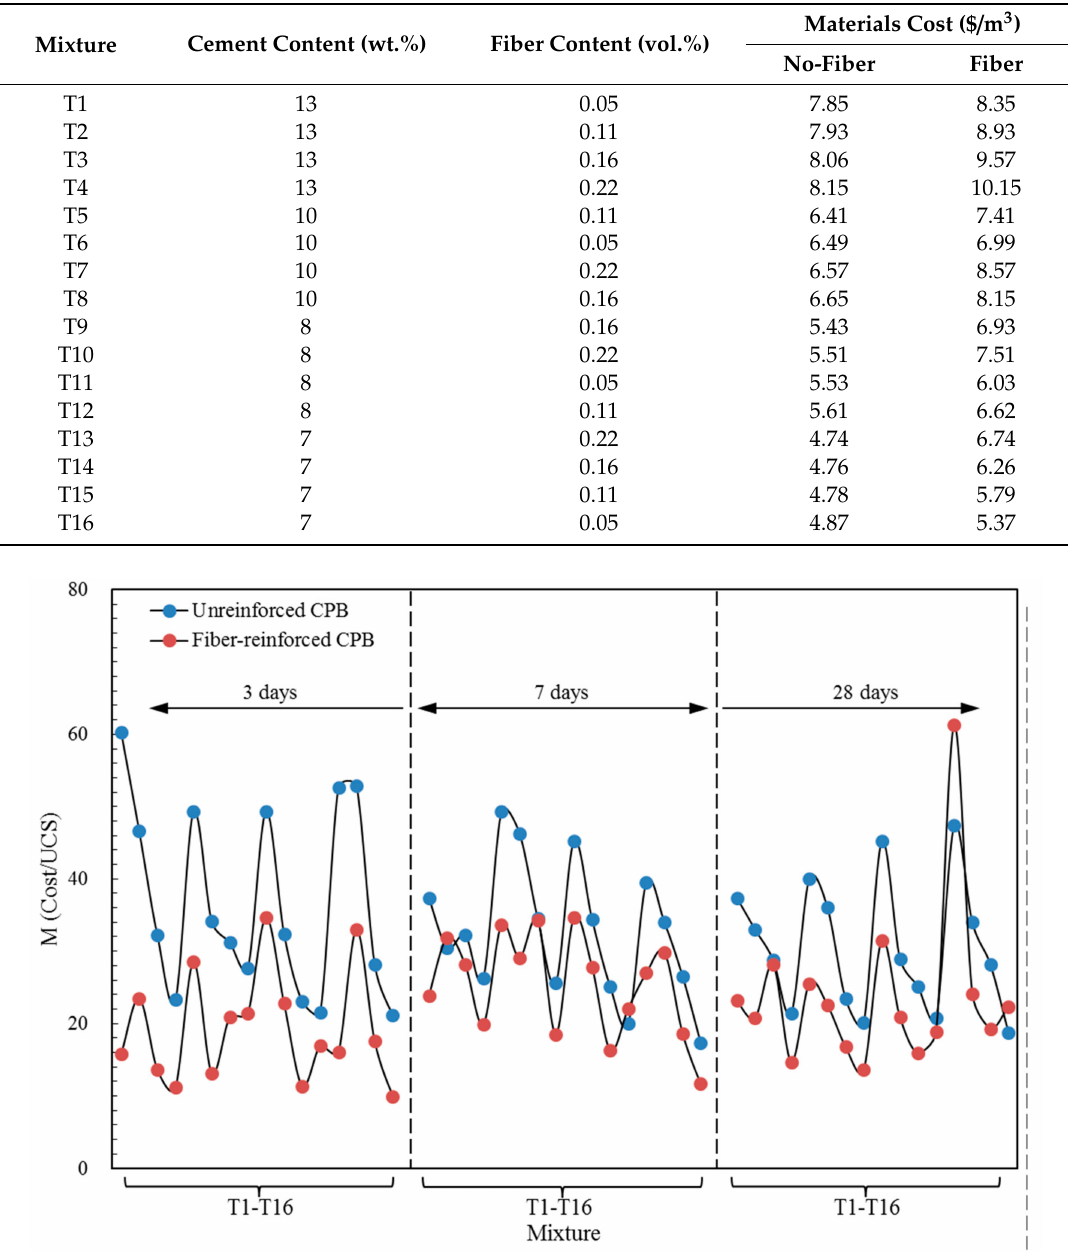
Table 7. The influence of adding fiber on the materials cost of CPB.